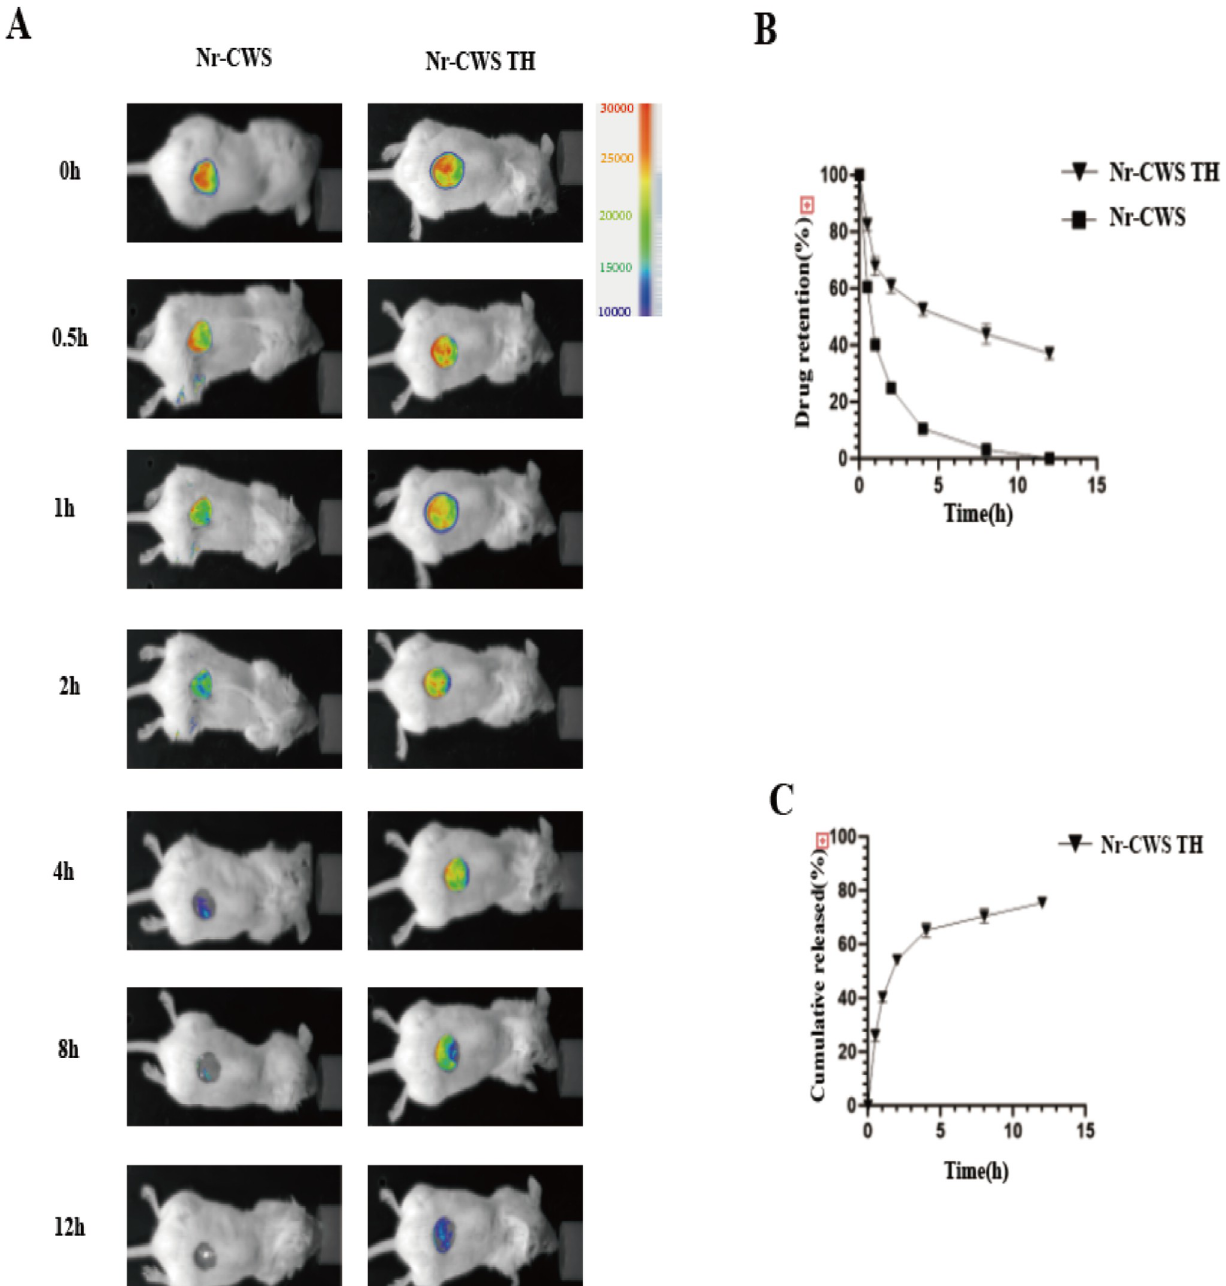
Fig 3. The rate and condition of wound healing. The continuous release of N-CWS from N-CWS TH hydrogel in vivo and vitro. A) After the wounds were formed, N-CWS stained with Cy5 were injected into mice. The continuous release of N-CWS from PBS and N-CWS TH hydrogel around the wound was analyzed by in vivo imaging. B) Statistical analysis of the continuous release of N-CWS in vivo; C) Release profile of N-CWS TH at different time points in